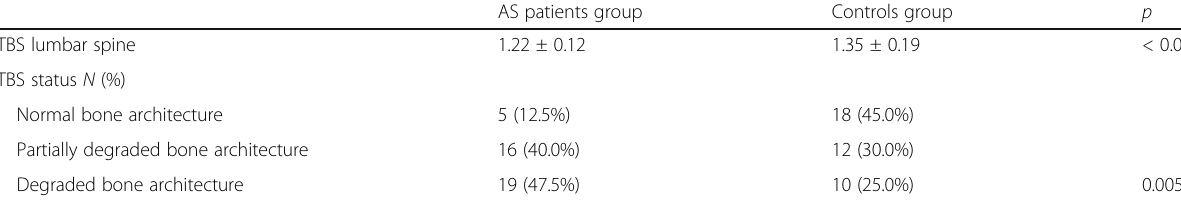
Table 3 Comparison of TBS between AS patients and controls AS patients group Controls